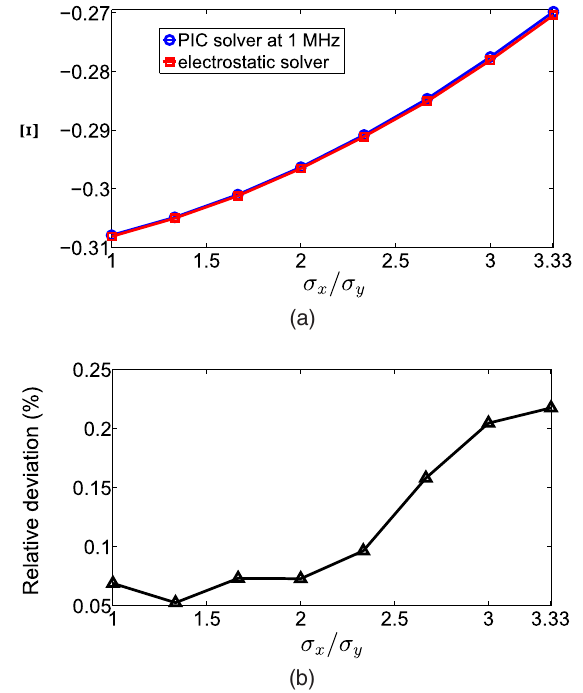
FIG. 20. (a) Ξ as a function of σ x = σ y , σ y ¼ 7 . 5 mm; (b) relative deviation of the quadrupole signal obtained with the PIC solver of CST PS from the quadrupole signal obtained with the electro- static solver of CST